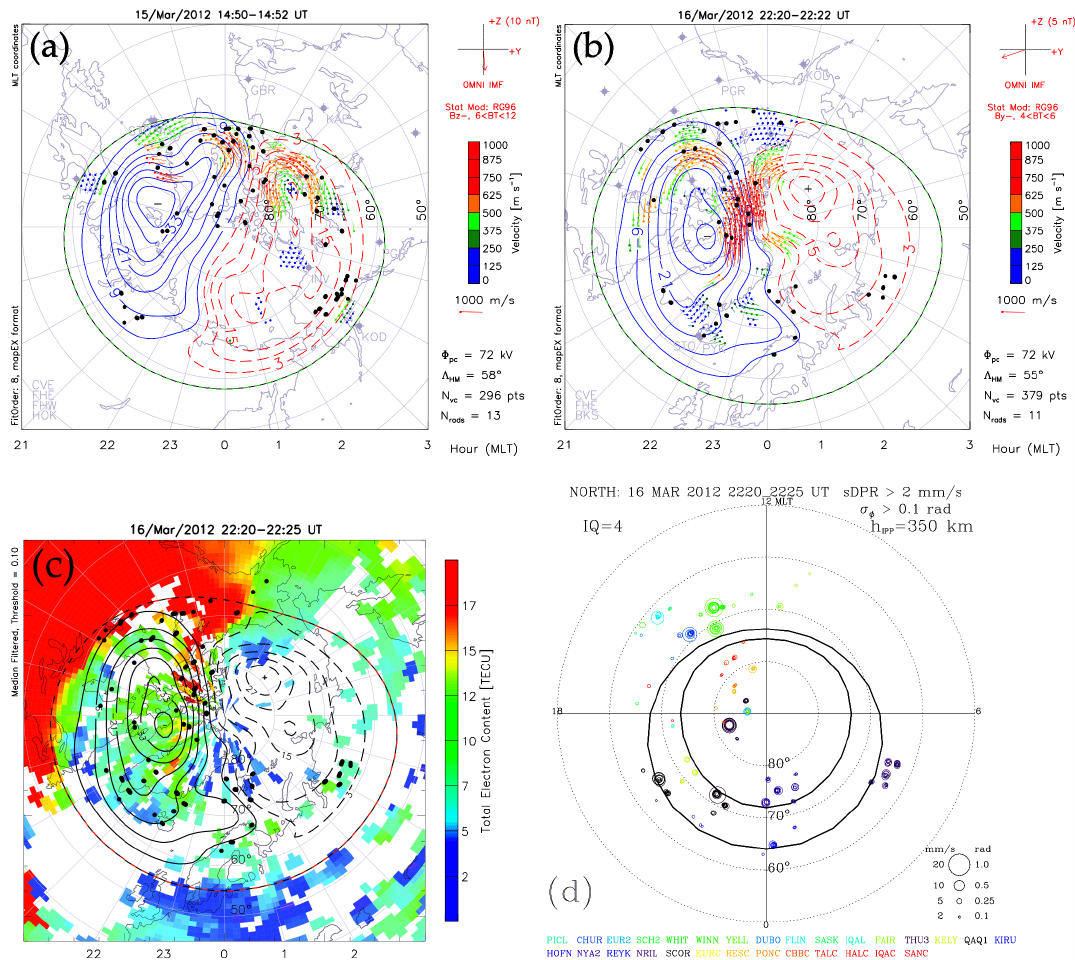
Figure 15. (a–b) Event S4: SuperDARN convection and potential maps on 15 and 16 March. The IPPs for PRNs with σ (cid:56) >0.1rad and/or sDPR>2mms − 1 are superposed as black dots. (c) The 5min median-filtered TEC mapped in coordinates of AACGM latitude and MLT is overlaid with the SuperDARN potential map and IPPs (black dots) for σ (cid:56) >0.1rad or DPR>2mms − 1 . (d) The IPPs are shown as circles scaled proportionally to σ (cid:56) and sDPR